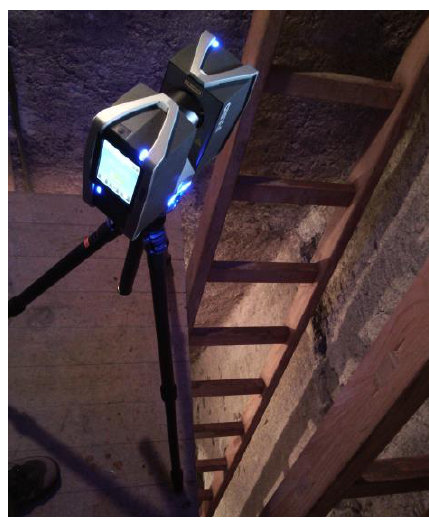
Figure 6. Position of the FARO Focus during a scan inside the